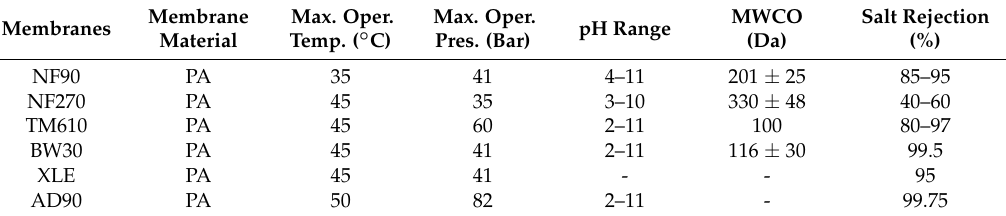
Table 3. Properties of NF/RO